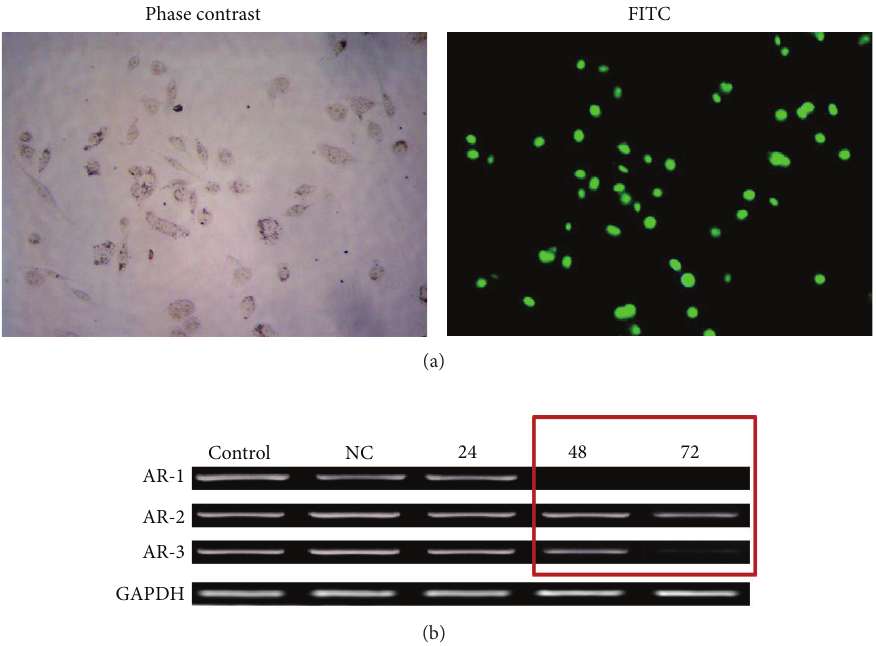
Figure 1: Effective silencing of the androgen receptor (AR) gene expression in ls-LNCap cells after small interfereing RNA (siRNA) treatment. (a) Transfection efficiency shown by fluorescence microscopy; (b) RT-PCR band of AR from si-ls-LNCap cells after siRNA. CNTL, untreated siRNA; NC, treated scrambled